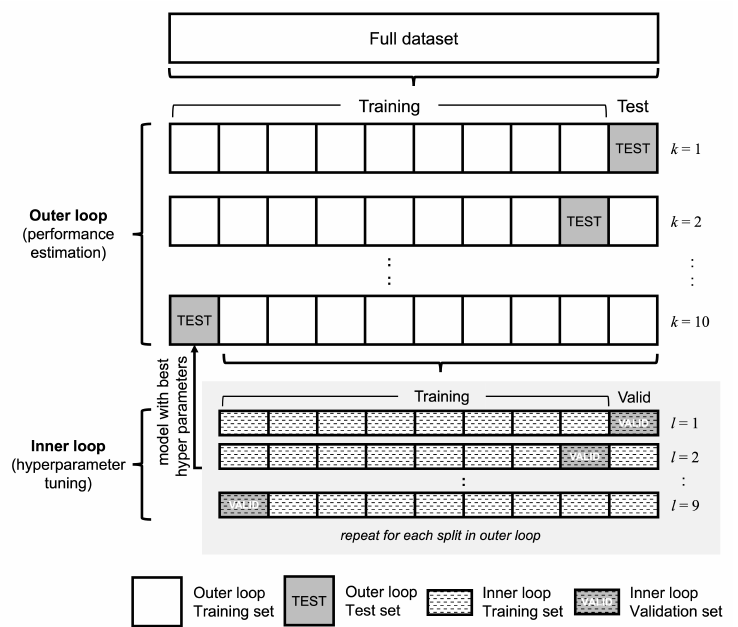
Figure 8. Diagram of nested cross validation with ten outer folds and nine inner folds that were used in this study. The nested cross validation scheme resulted in all images being used for